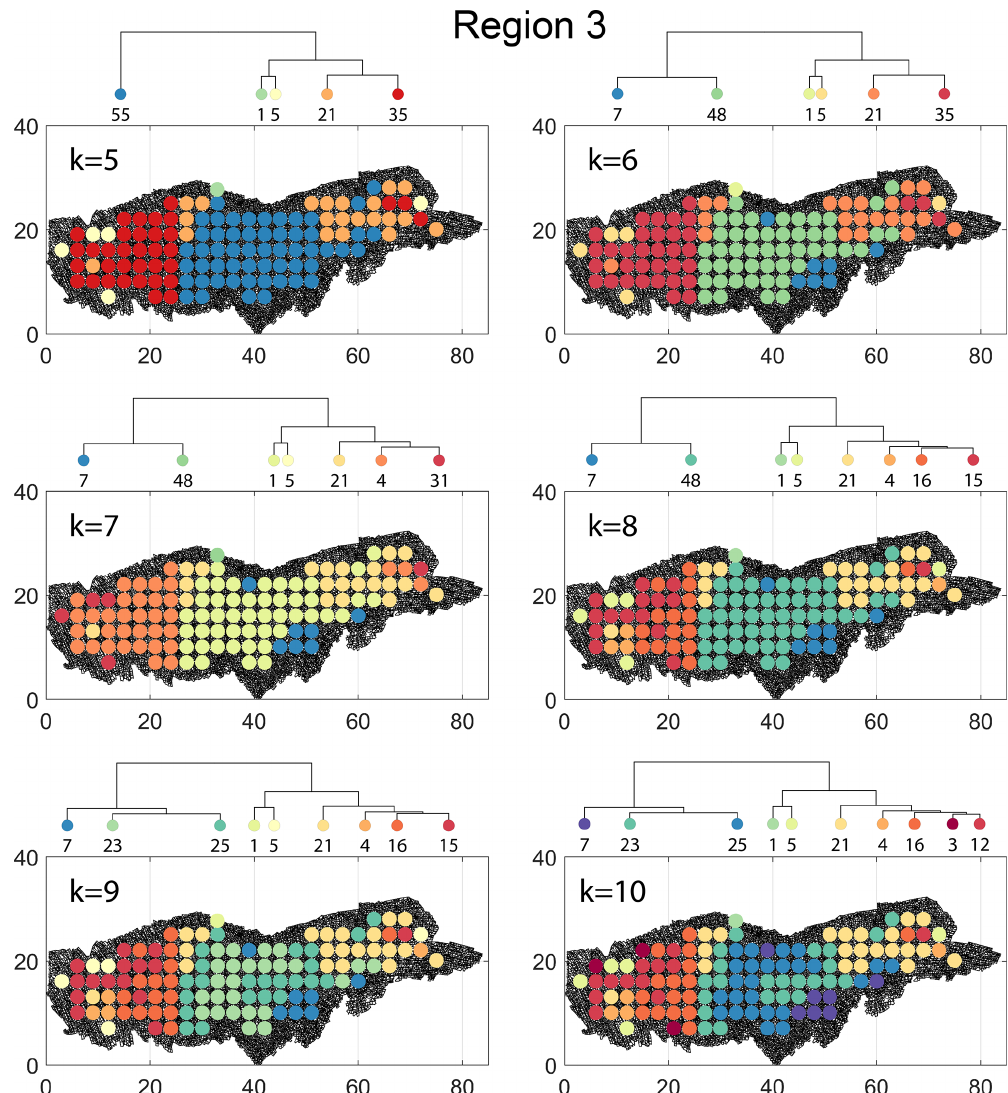
Figure B12. Variation in cluster boundaries for “ k ” clusters in Region 3 using portrait